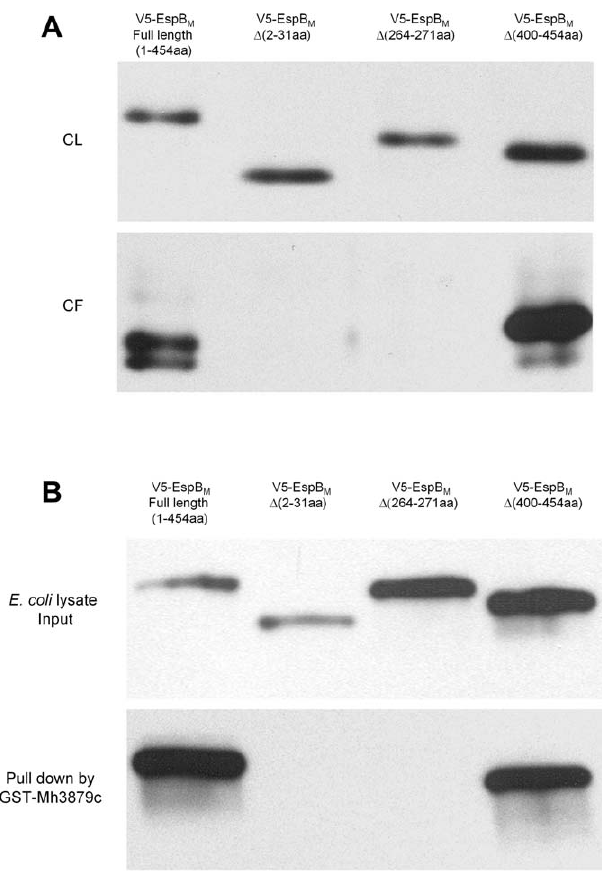
Figure 6. Deletion Analysis of EspB M Secretion and Interaction with Mh3879c (A) The M. marinum espB M ::tn mutant was transformed with a non- integrating plasmid expressing N-terminally V5-tagged EspB M full length, EspB M D (2–31), EspB M D (264–271), or EspB M D (400–454). Cell lysates (CL) and culture filtrates (CF) were prepared from the indicated strains as described in Materials and Methods. The samples of each strain are normalized by OD readings. Of the total CL and CF fractions collected for each strain from one experiment, 3% of the CL was loaded in each lane and 15% of the total CF was loaded into each lane, separated by SDS- E. coli lysates expressing V5-tagged EspB M full length, EspB M D (2–31), EspB M D (264–271), or EspB M D (400–454). The input lysate (0.1%) and the